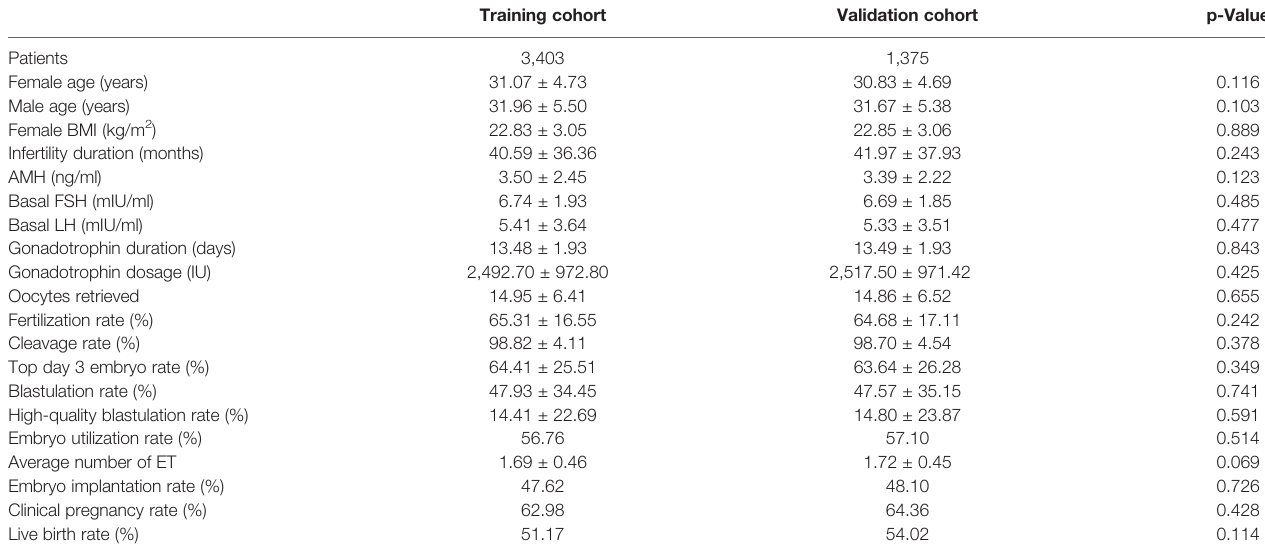
TABLE 1 | Characteristics of tubal factor group in the training and validation